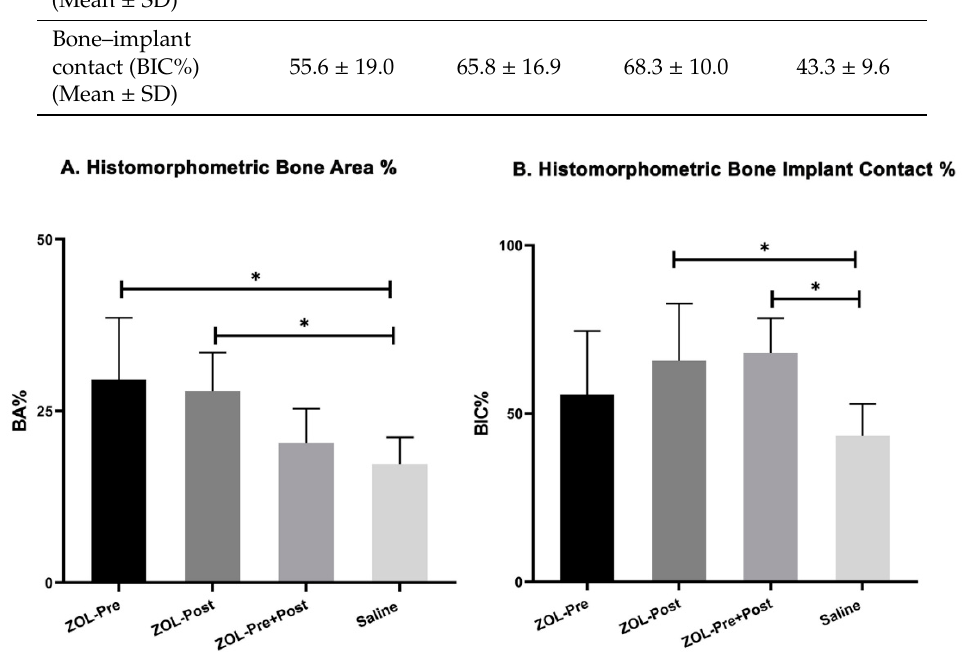
Figure 7. Bar chart with mean and standard deviation for ( A ) BA% and ( B ) BIC% in all study groups. ( * indicates p < 0.05).